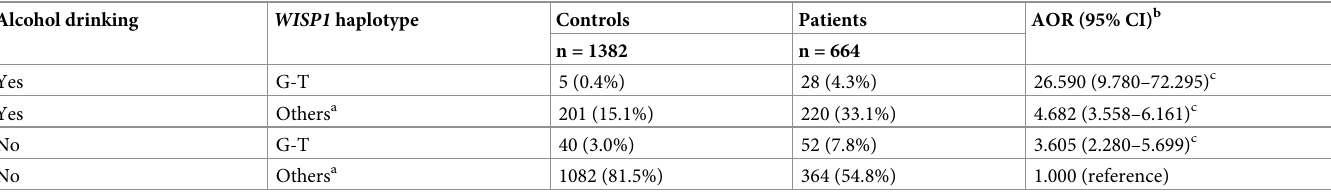
Table 7. Combined effect of alcohol drinking and WISP1 haplotypes on HCC